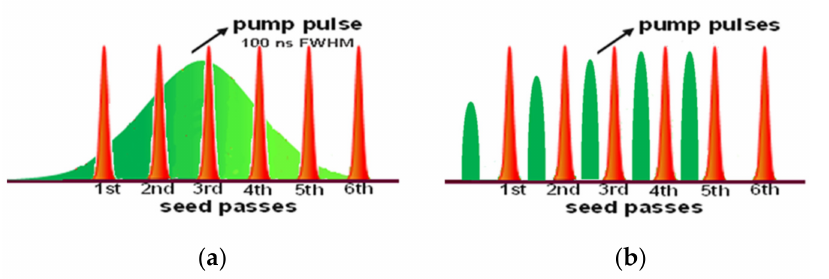
Figure 3. EDP method of pumping and amplifying: ( a ) extended pump pulse; ( b ) several de- layed